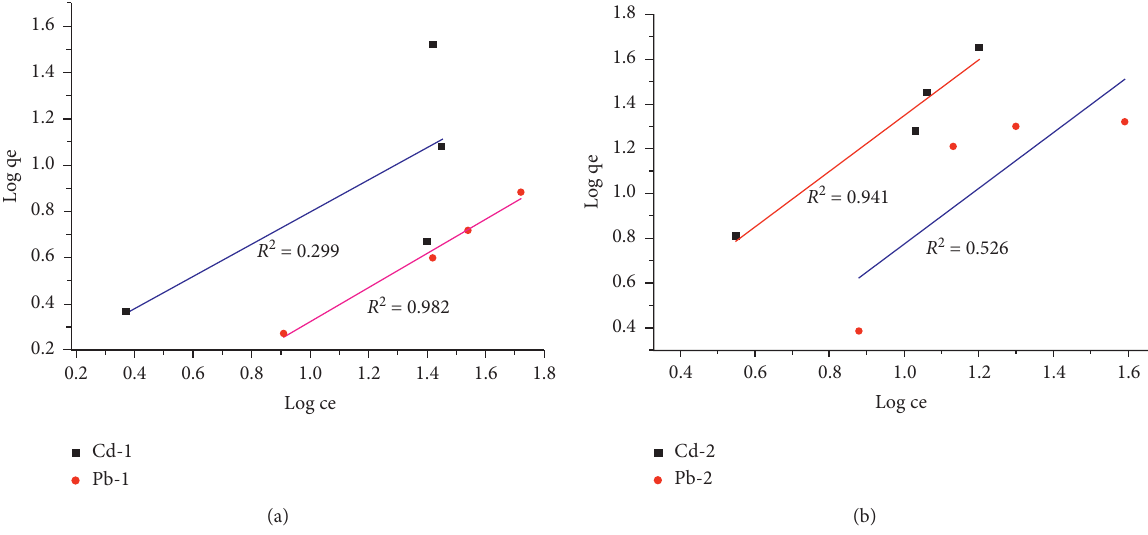
Figure 6: Freundlich isotherm for Cd (II) and Pb (II) adsorption on clay-1 (a) and clay-2